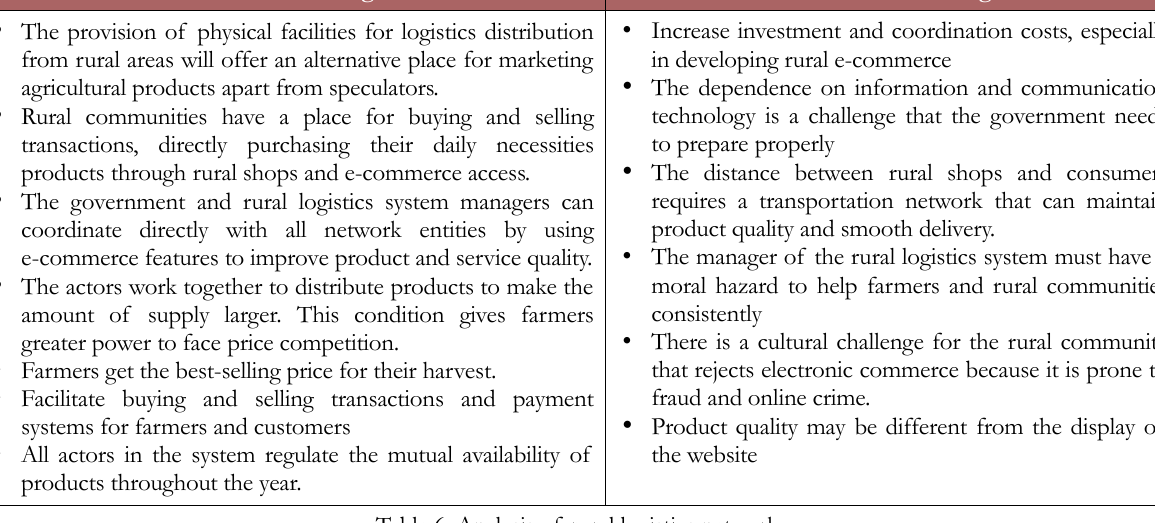
Table 6. Analysis of rural logistics network